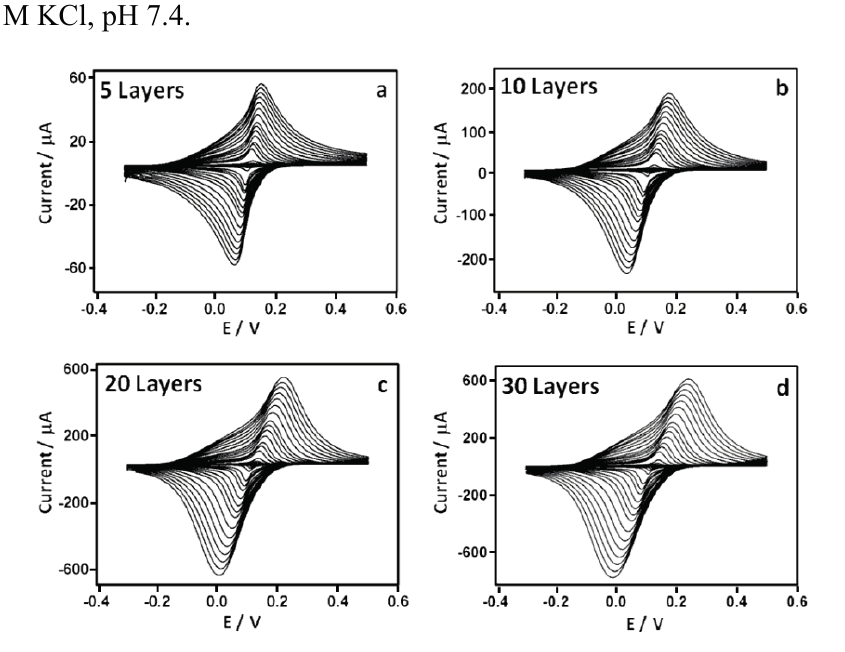
Figure 4. Cyclic voltammograms of PBNP-modified SPEs with ( a ) 5, ( b ) 10, ( c ) 20 and ( d ) 30 layers. Scan rates were from 10 to 1000 mV·s − 1 vs . Ag/AgCl in 0.05 M phosphate buffer, 0.1 M KCl, pH 7.4.